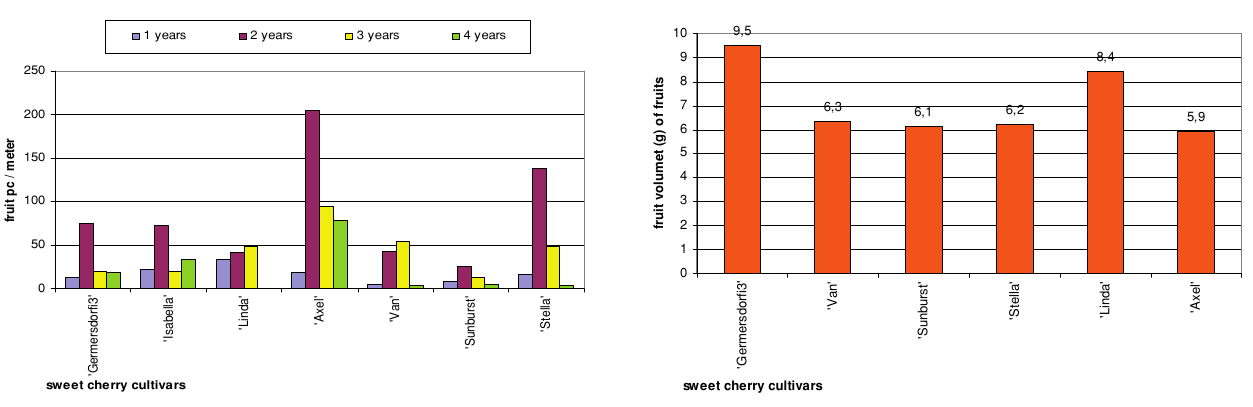
Figure 5: Fruit volume (g) of fruits in sweet cherry varieties (Debrecen- Pallag, 2009) Figure 6: Dimensions of cherry fruits and the length of fruit stems in the varieties examined (Debrecen-Pallag, 2009) Table 2. The performance (yields and fruit characters) of sweet cherry varieties (Debrecen-Pallag, 2009)